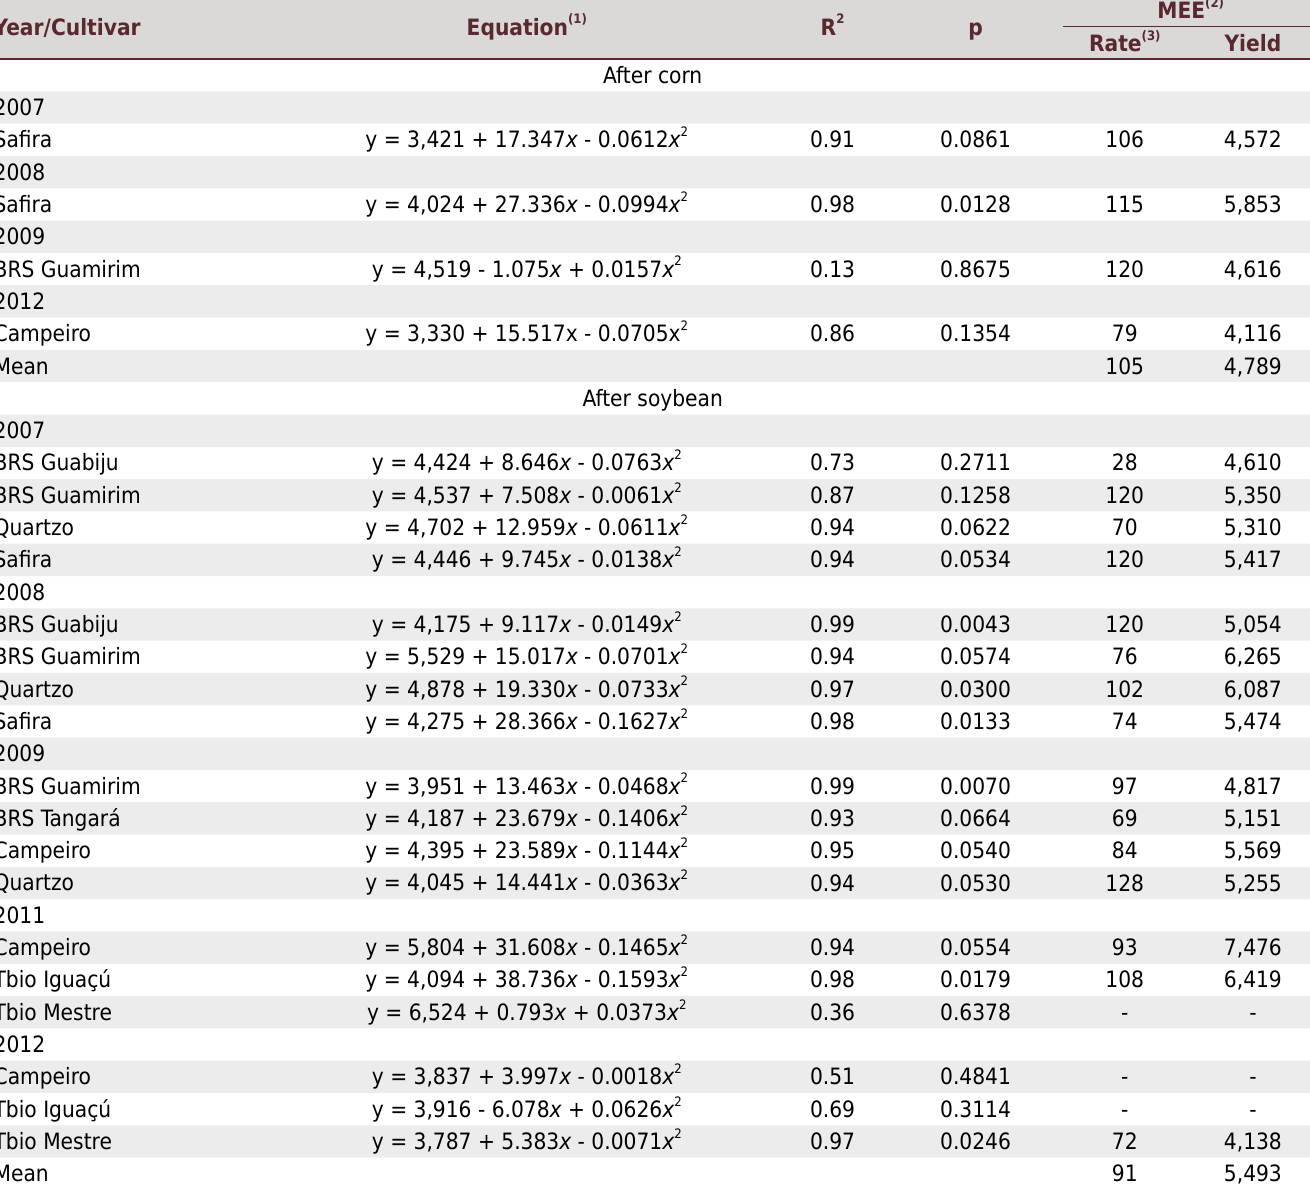
(1) Only for experiments with a quadratic yield response to N fertilization. (2) Maximum economic efficiency (kg ha -1 ). (3) Fertilizer to grain price ratio (price of the kg of N per price of the kg of wheat grain) = 4.362 (2007 to 2012 average). R 2 : coefficient of determination; p: significance